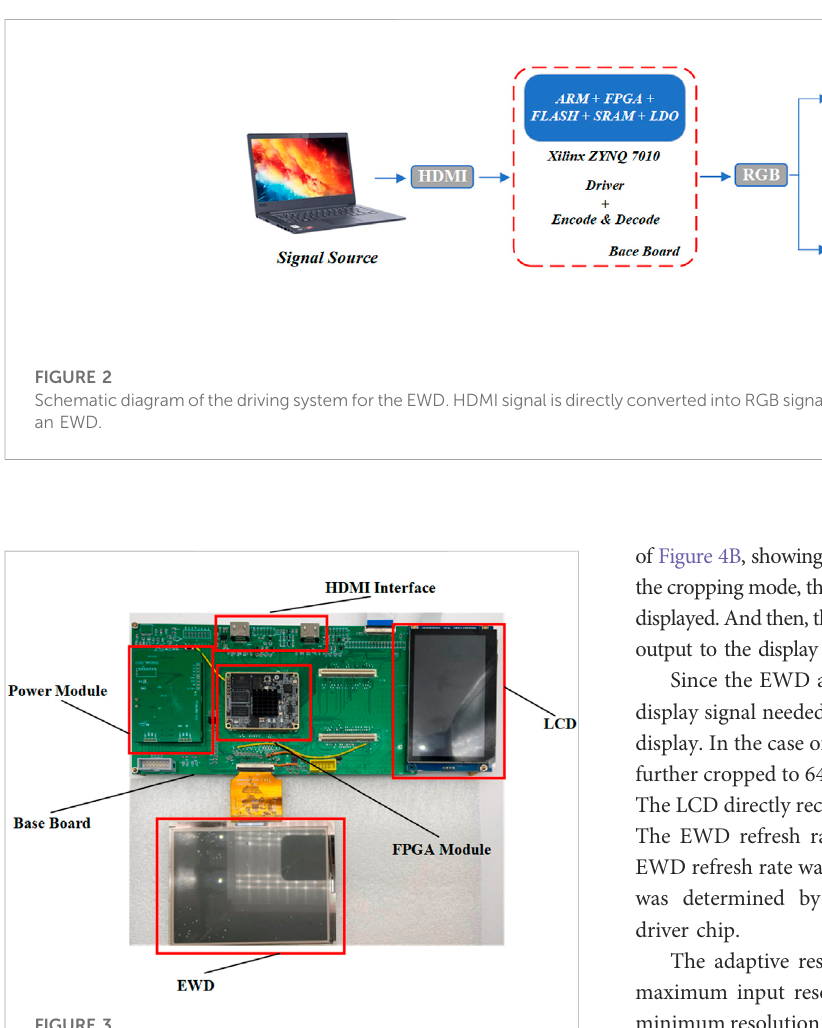
FIGURE 3 A physical fi gure of the driving system for